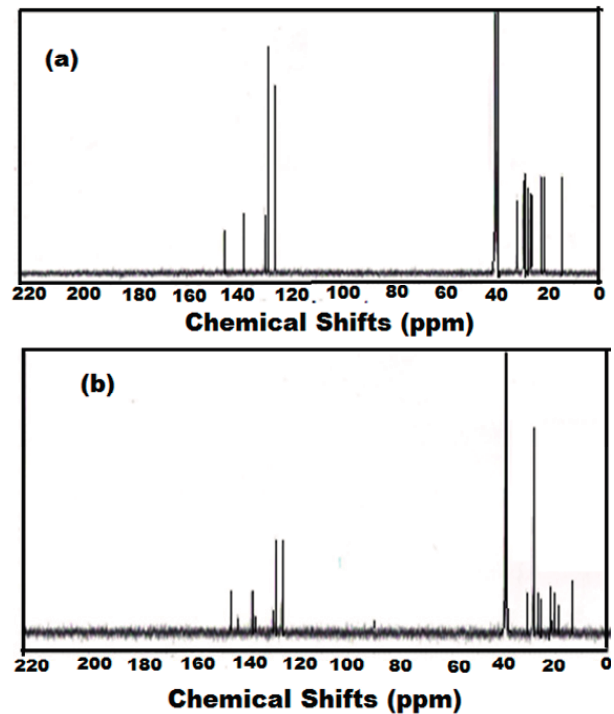
Figure 2. 13 C-NMR spectra of ( a ) OA-TS and ( b ) ODA-TS.